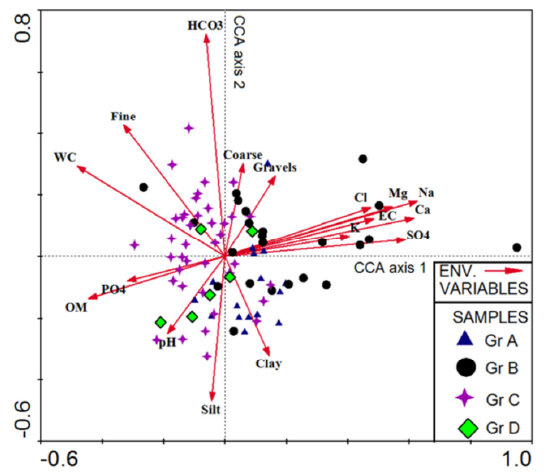
Fig. 3. DCA diagram showing the distribution of the studied 84 stands within their vegetation groups (A-D)